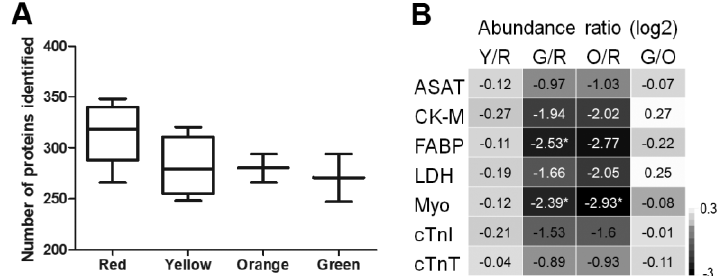
Figure 4. Identified proteins in the different clusters. ( A ) The number of proteins identified in the cluster replicates, and ( B ) heatmap showing the abundance ratio (log2) of classically known cardiac biomarkers. * indicates adjusted p -value ≤ 0.05. R = Red; Unaffected tissue, Y = Yellow; Unaffected interstitial stromal tissue, O = Orange; Infarct border, G = Green; Infarct core. Where Y/R is the ratio of Yellow versus Red. ASAT = Aspartate aminotransferase, CK-M = creatine kinase-M type, FABP = fatty acid-binding protein, LDH = lactate dehydrogenase, Myo = myoglobin, cTnI = cardiac troponin I, cTnT = cardiac troponin T.